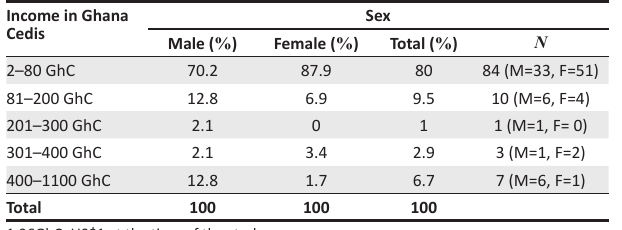
TABLE 8: Respondents sources of income by sex ( N = 105 Females 58 and Males 47).